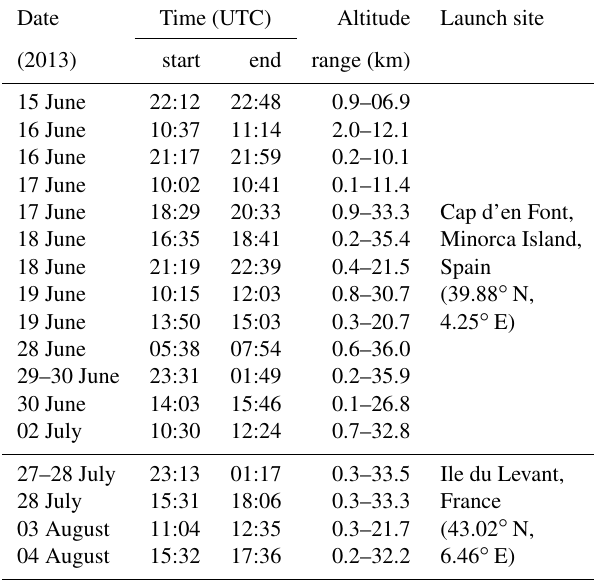
Table 1. List of the 17 LOAC flights under light dilatable balloons (LDB) flown during African dust plume events of the ChArMEx summer 2013 campaign.